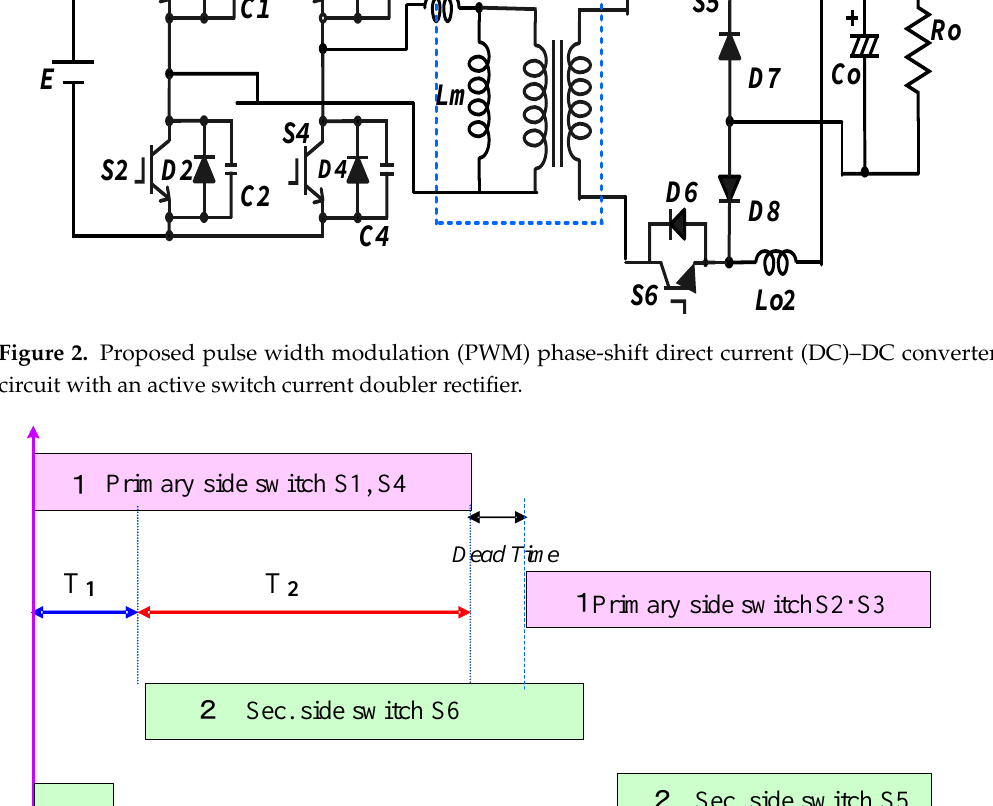
Figure 3. Pulse timing of the voltage signal of each switch.